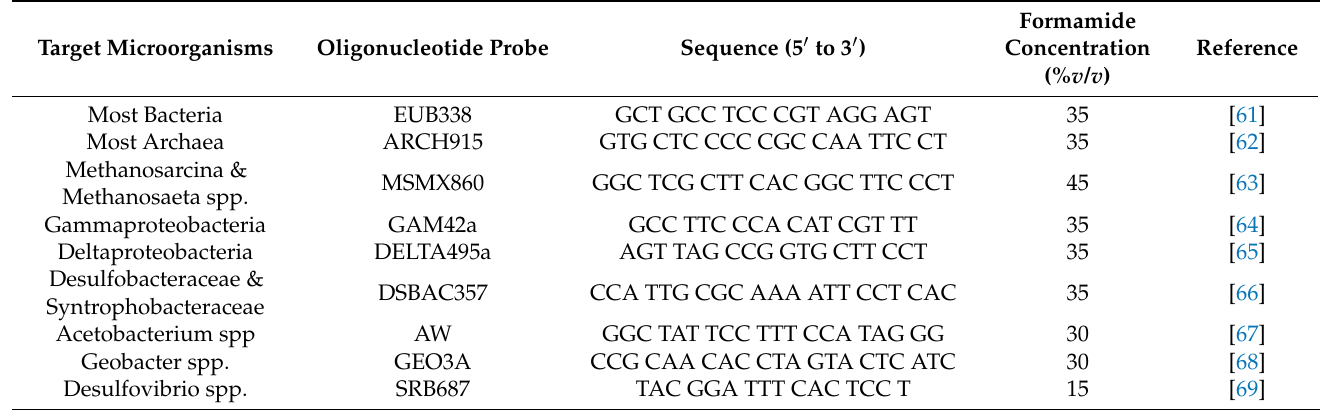
Table 4. Probes used for FISH